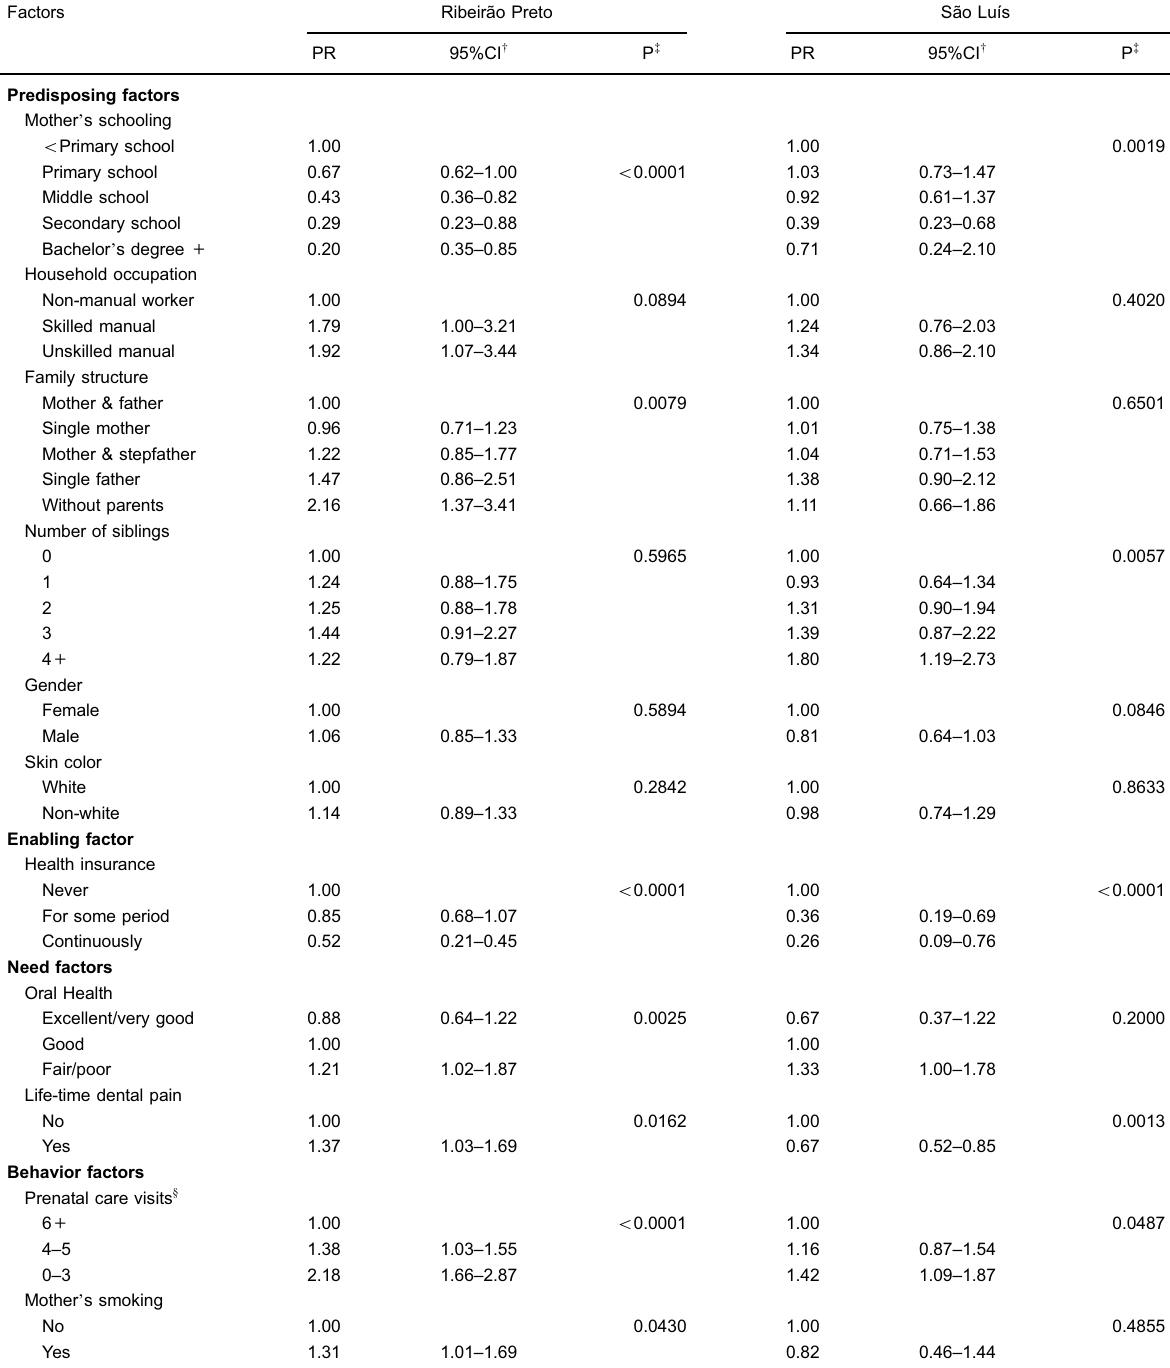
Table 3. Multivariable analysis for each level of predisposing, enabling, need, and health behavior factors. Results showing prevalence ratios (PR) for covariates for children who did not visit a dentist before the age of 7 in the Ribeirão Preto and São Luís cohorts (2004/